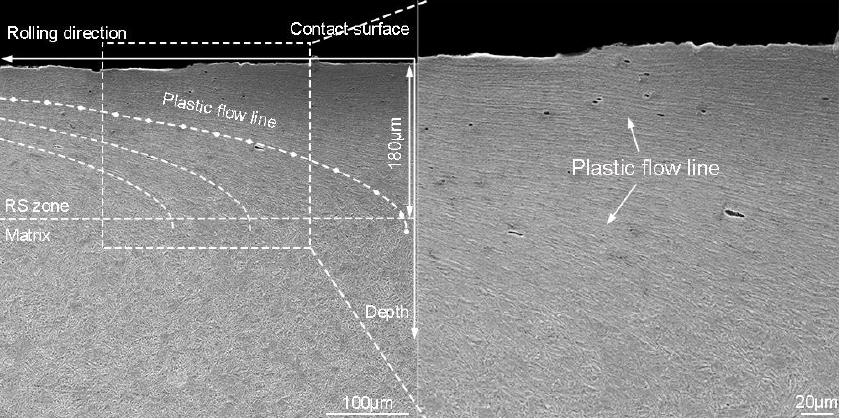
Figure 6. FESEM images of plastic flow lines in the RS zone.